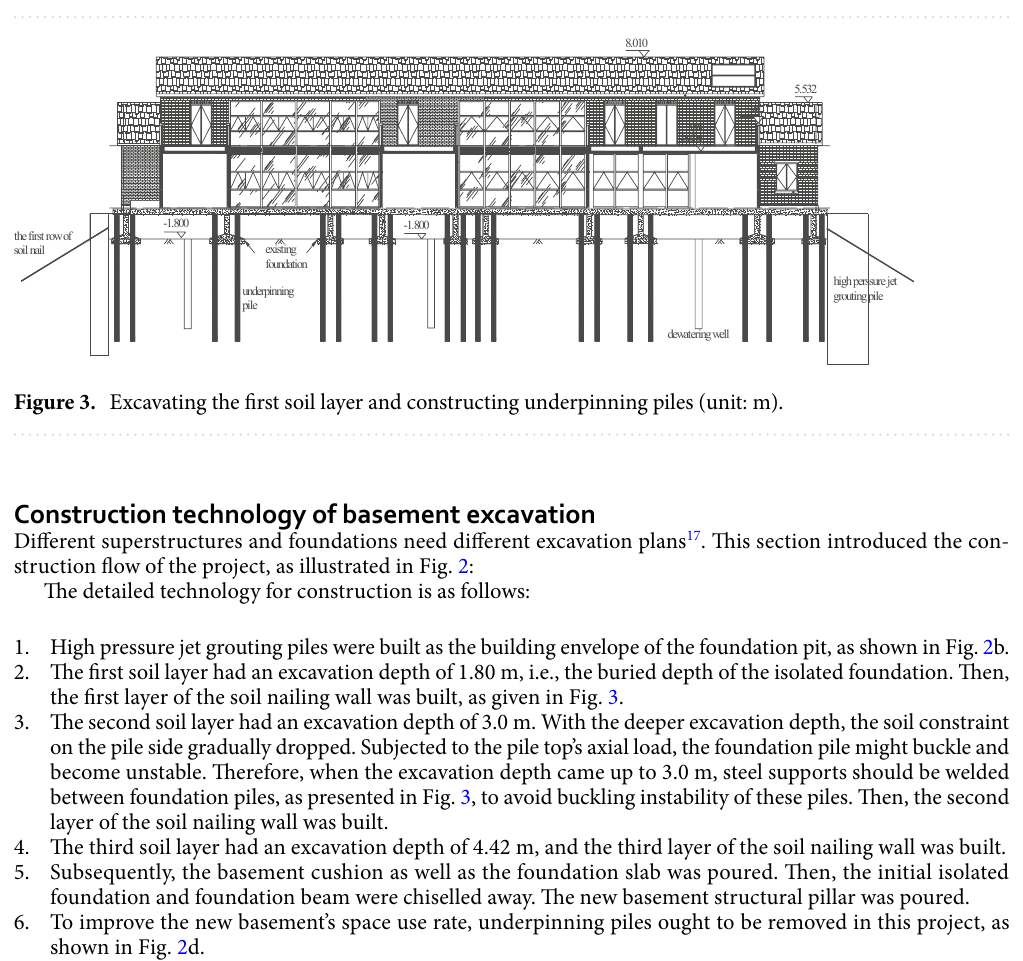
Figure 2. Construction flowchart of the Ganshuixiang project.